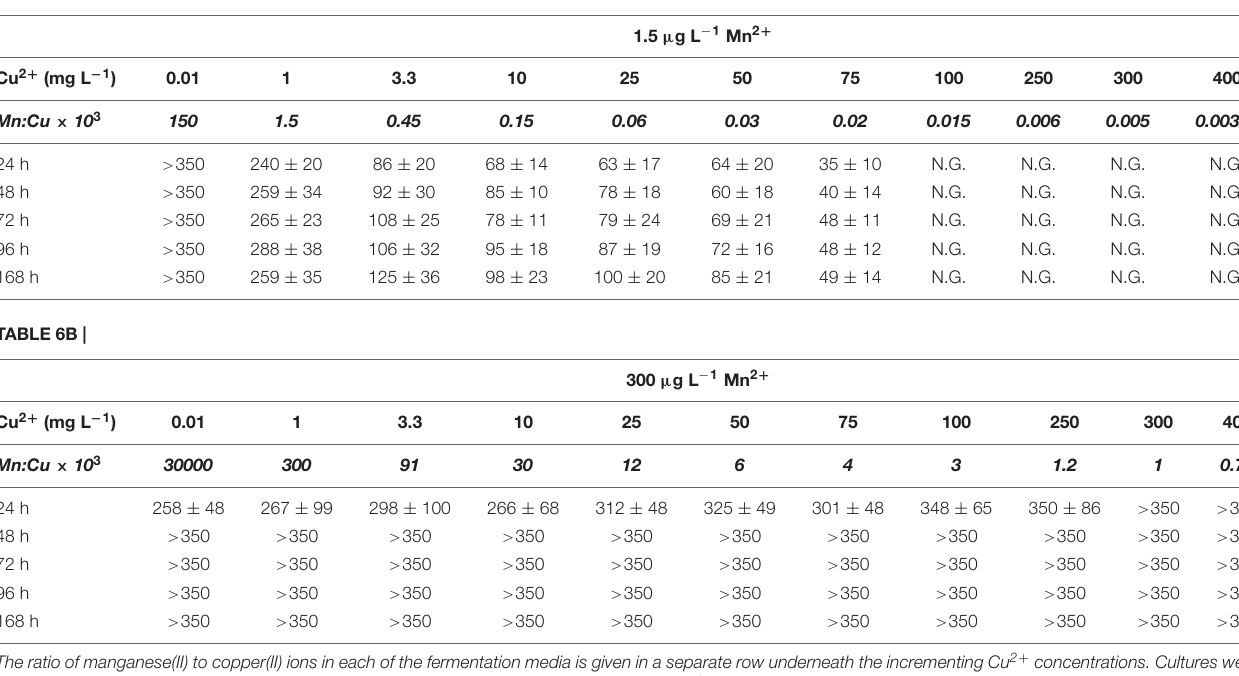
TABLE 6A | Average pellet size in A. terreus NRRL1960 D -xylose-grown cultures as a function of the copper(II) ion concentration in the medium at Mn 2 + limitation and